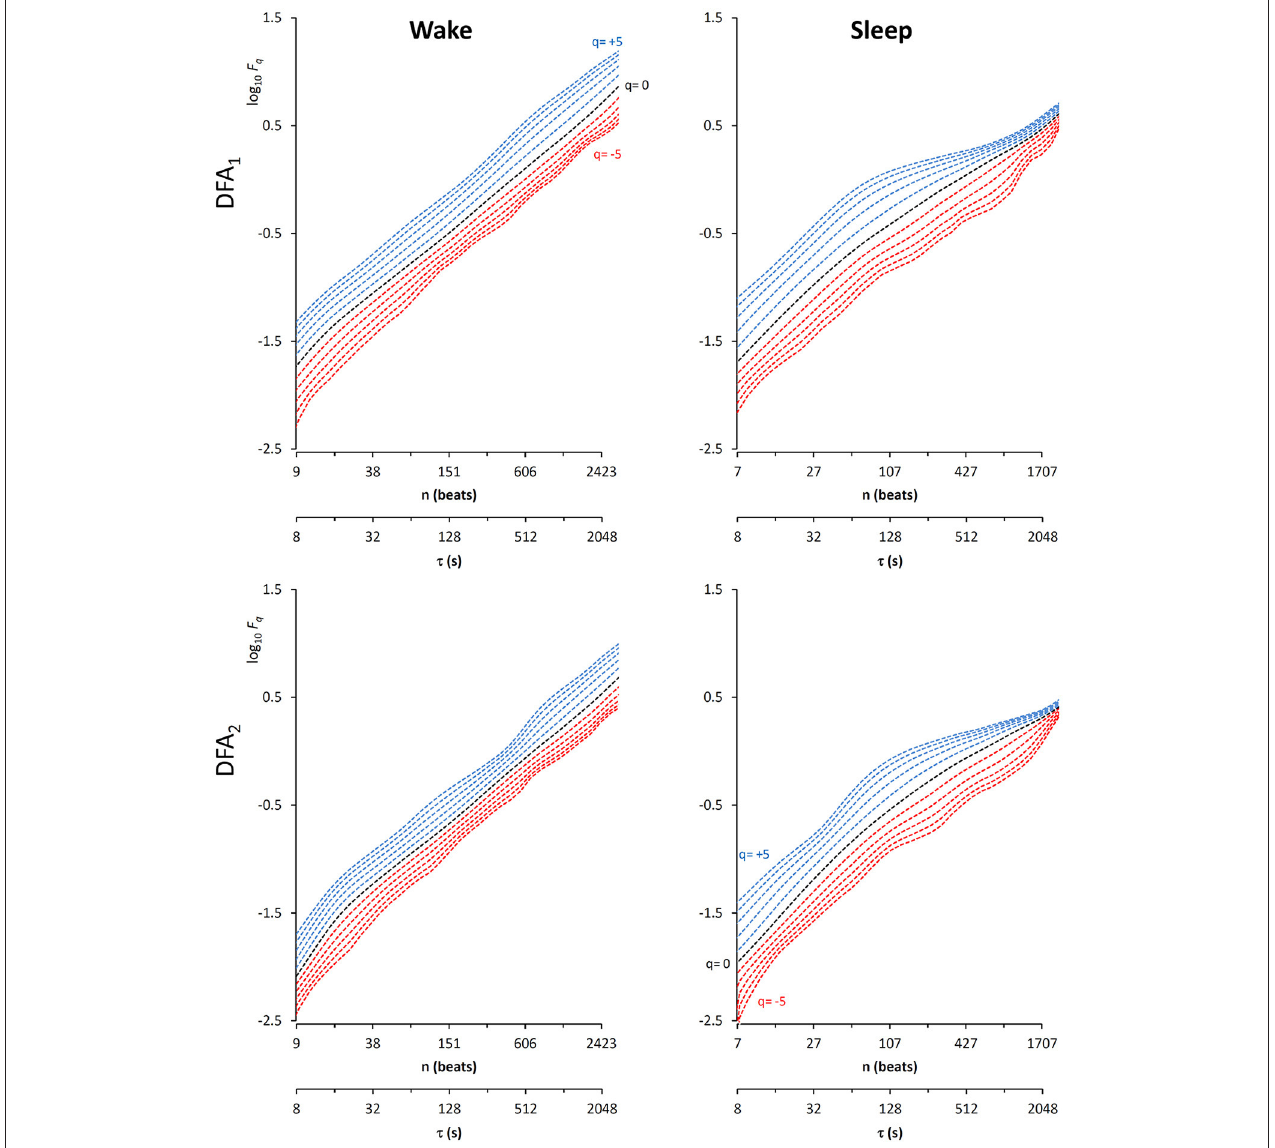
FIGURE 8 | Multifractal fluctuation functions of heart-rate variability during Wake and Sleep with maximally overlapped blocks. The original series are two 4-h segments of beat-by-beat R-R intervals from a 24-h ECG recording in a healthy volunteer. The first horizontal axis is the box size n , in number of beats; the second horizontal axis is the temporal scale τ , in seconds, obtained multiplying n by the mean R-R interval, which is shorter in Wake than in Sleep . Thresholds Th 1 and Th 2 as in Equations (19) and EPS = 0.